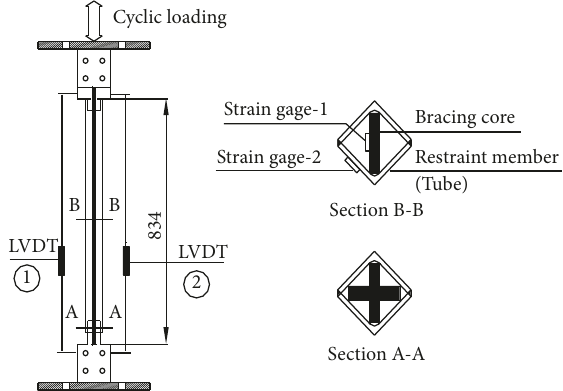
Figure 7: Schematic test setup and cross sections of SBRB